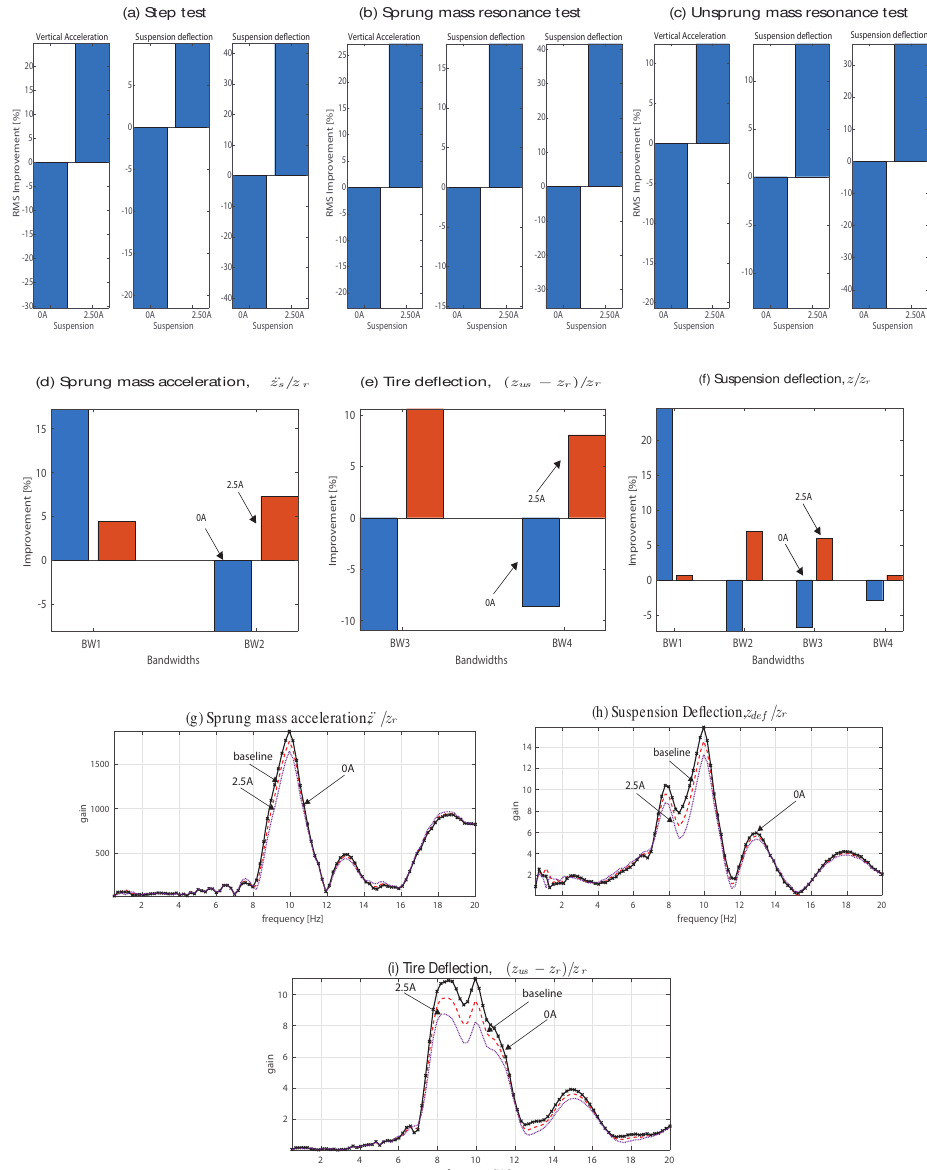
Figure 15. Results from open loop simulations for the comparison in a nonlinear modified QoV model considering a 1.25 A baseline suspension and the residual vertical